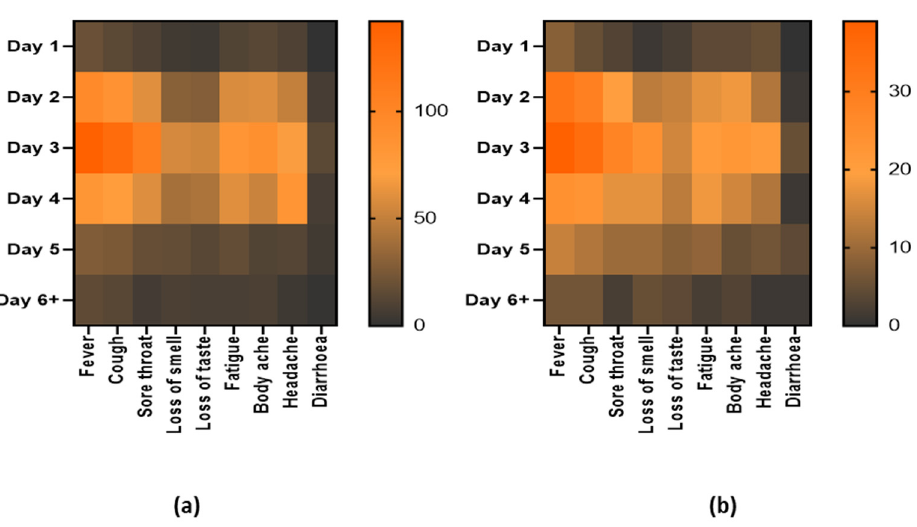
Figure 4. Heat maps representing the major symptoms of patients. From day 1 to day 6 and above post onset of symptoms for ( a ) patients coming to the diagnostic facility for the test and ( b ) patients who are positive by the OnSite ® COVID-19 Ag RDT. The right-sided bar in each heat map represents the number of patients in each group.